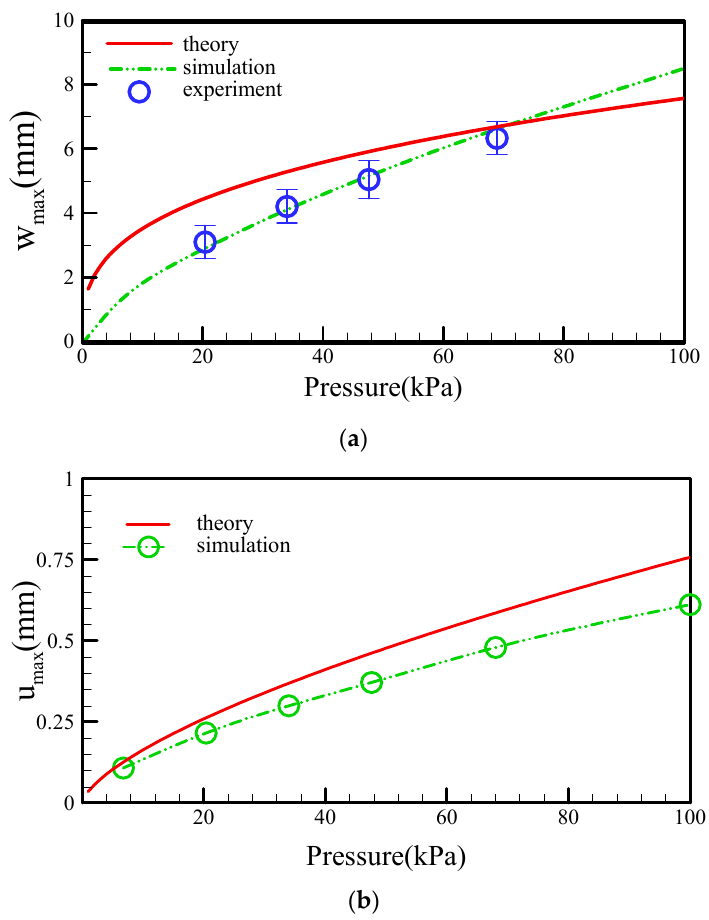
Pressure(kPa) Figure 7. Comparisons of theoretical, numerical, and measured data for ( a ) w max and ( b ) u max with a diameter of 18.0 mm against different air pressures.